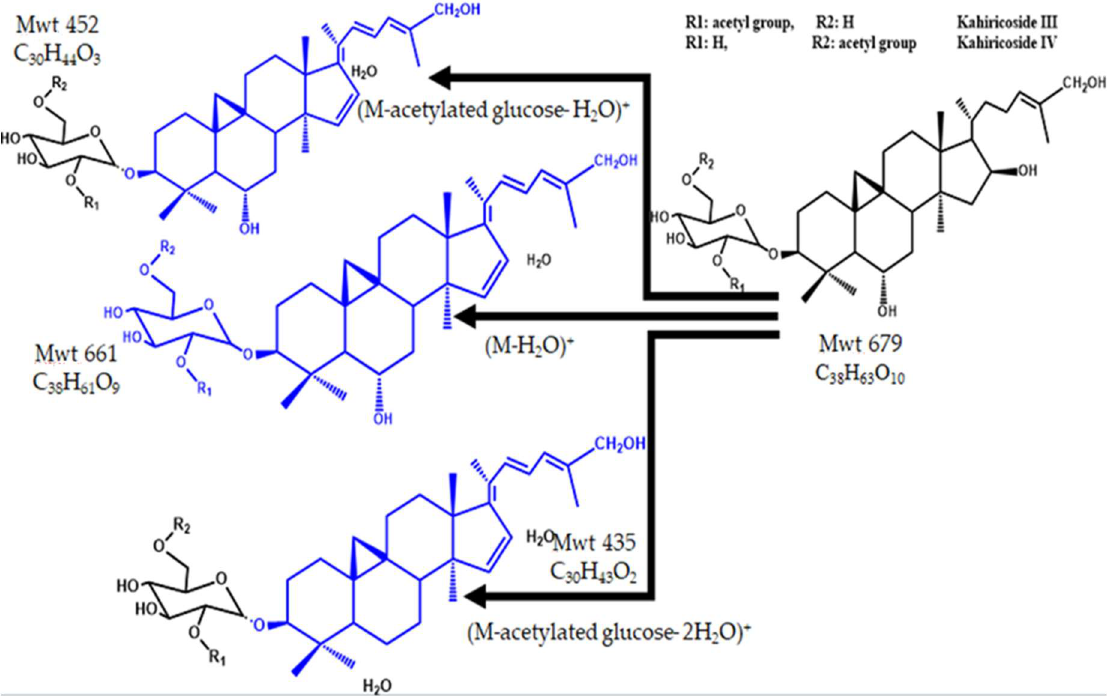
Figure 9. The structure and fragmentation of kahiricoside III and